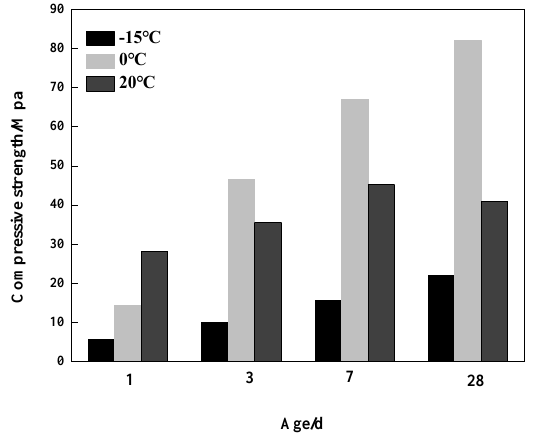
Figure 6. Compressive strength development of the samples at different temperatures.